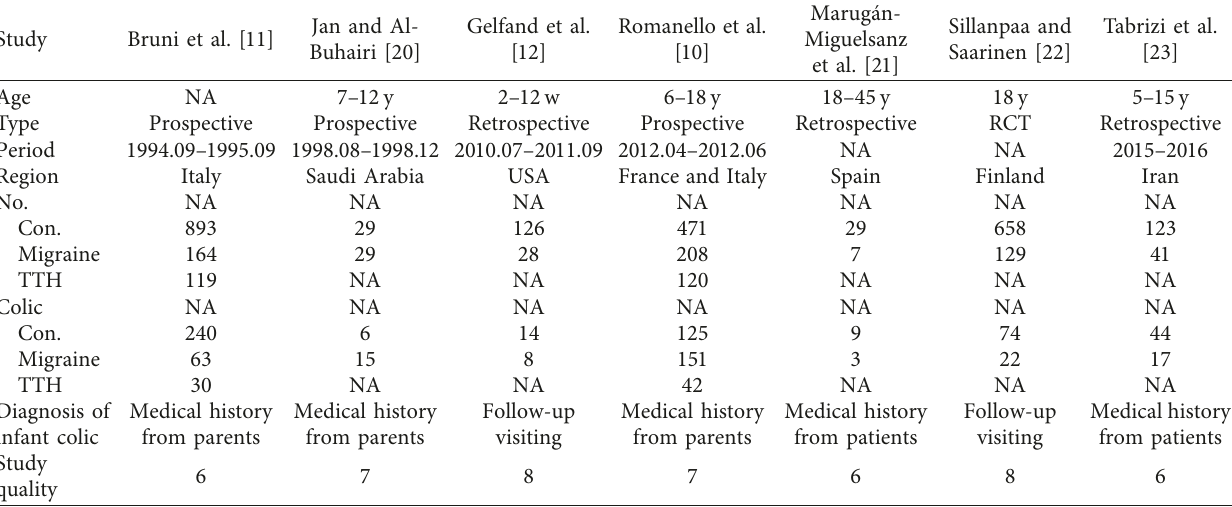
Figure 1: The flow diagram of the meta-analysis. Table 1: The baseline characteristics of the included